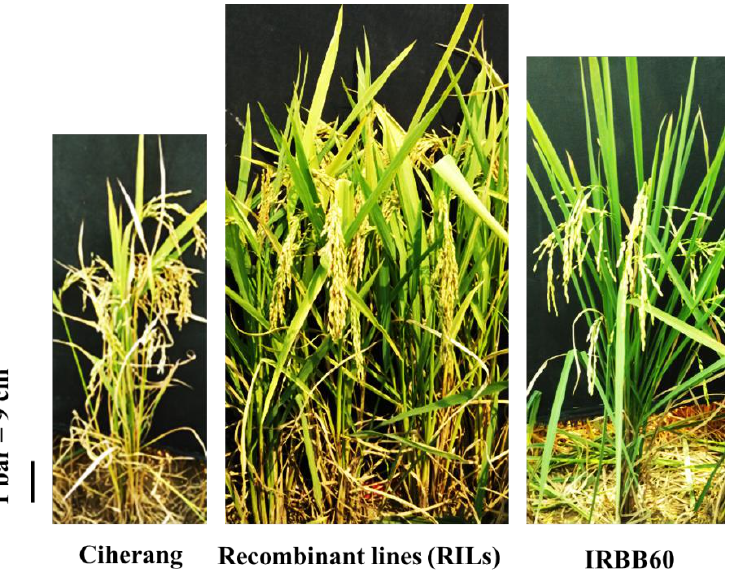
Figure 7. Morphological features of the recipient (Ciherang), donor (IRBB60) parents and their recombinant lines (RILs).